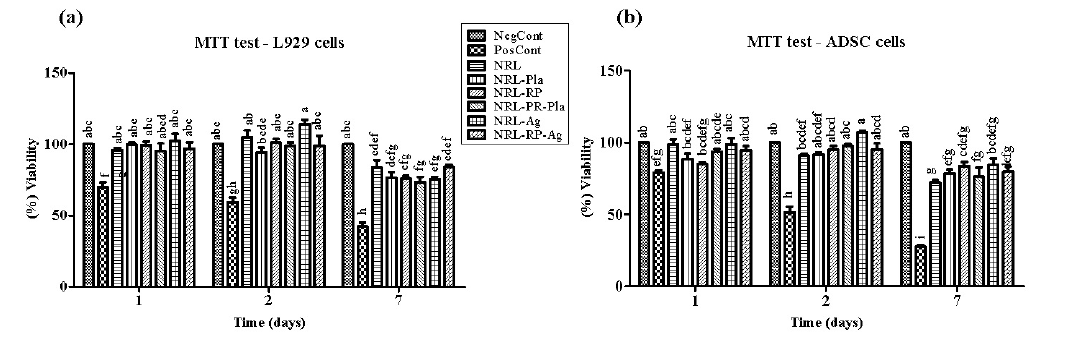
Figure 5. Cytotoxic effect obtained by the MTT indirect test according to ISO 10993-5-2009 42 and ISO 10993-12-2004 43 of the extracts compared to the negative (DMEM medium, 10% of FBS and 1% of P/S) and positive control (DMEM medium, 10% of SFB, 1% of P/S and 5% of DMSO) on the viability of (a) L929 and ADSCs (b), treated for 1, 2 and 7 days. NegCont: negative control; PosCont: positive control; NRL, NRL-Pla, NRL-RP, NRL-RP-Pla, NRL-Ag, NRL-RP-Ag films. * Letters (a, b, c, d, e, f, g, h and i) correspond to the statistically significant differences using the ANOVA-Tukey test (p ≤